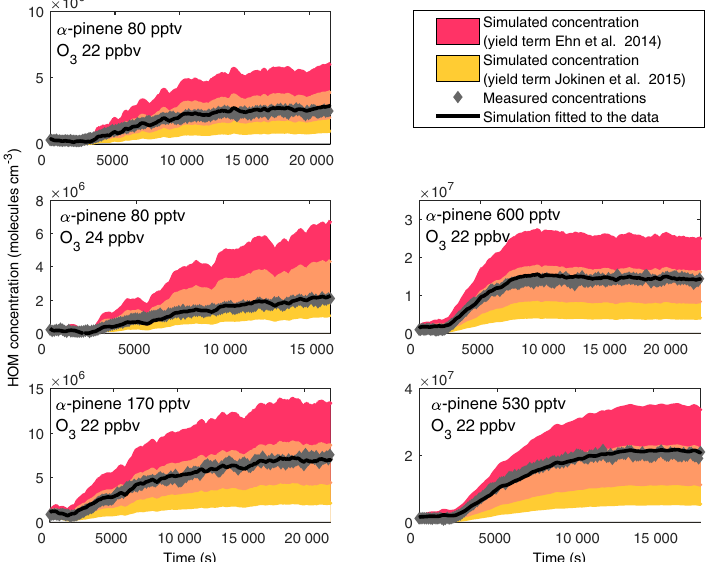
Figure 6. Measured (grey dots) and simulated (shaded area shows the concentration with uncertainty) HOM concentrations formed from the ozonolysis of α -pinene in the CLOUD chamber. The simulation with fitted yield term to the measured concentration is shown as a black line. The modelled concentration with a yield term from Ehn et al. (2014) is shown in red, while the concentration with the yield term from Jokinen et al. (2015) is shown in yellow. The overlapping area within the error estimates of these studies is coloured in